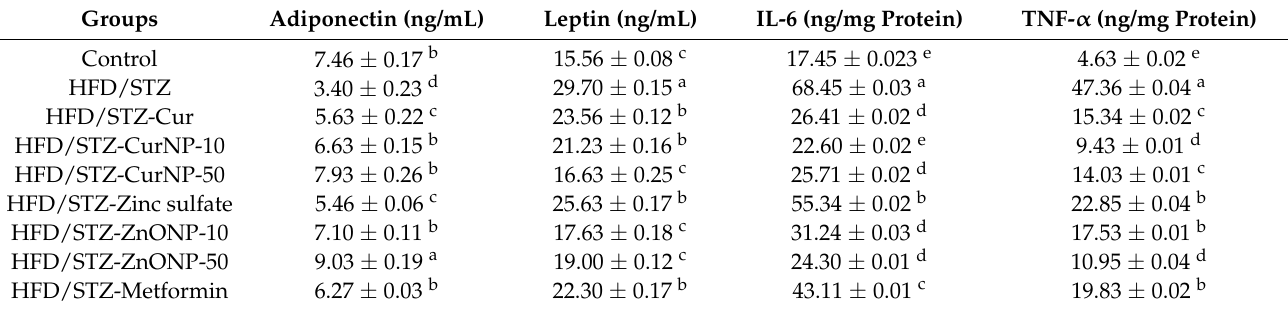
Table 3. Effect of CurNP and ZnONP on serum adipokines levels and hippocampus inflammatory biomarkers.